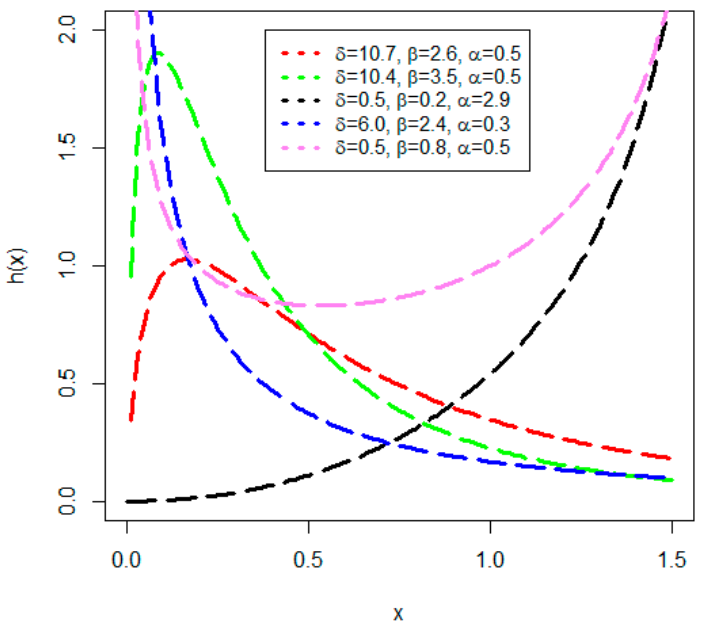
Figure 3. Plots of the h ( x ; δ , Θ ) HF of the NGLog–Weib ( ) ; , h x δ Θ HF of the NGLog–Weib model.